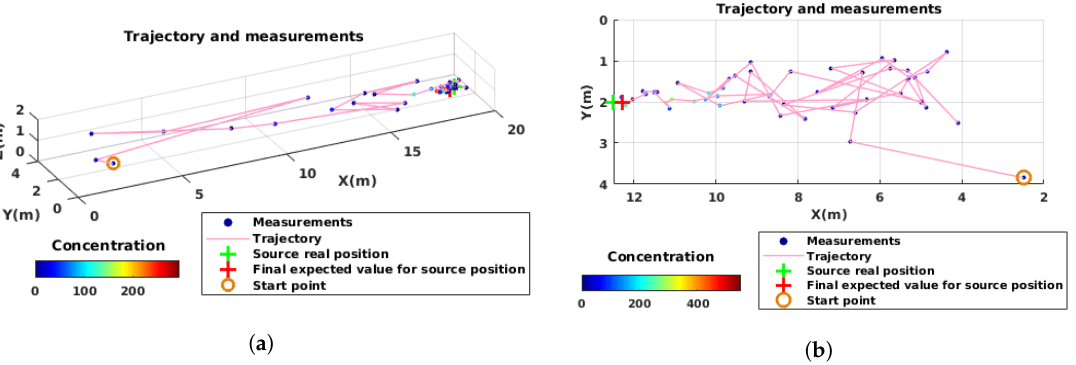
Figure 5. Two examples of robot’s trajectory in the global framework: ( a ) simulation; and ( b ) physical reality. The initial position of the robot, as well as the real position of the source and its predicted one are shown. On each sampled point, the measured concentration is indicated by the color of the circle, which corresponds to the averaged value of the measurements in a 5-s time window. The measured concentrations are relative values given by the sensor in